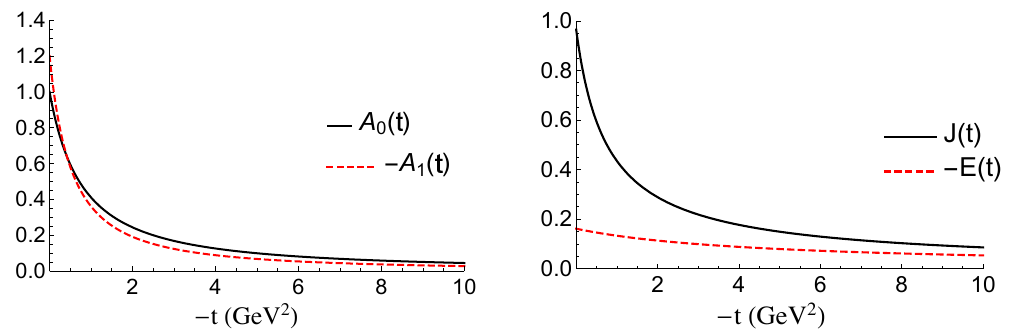
( t ) and A ( t ) , and (b) J ( t ) and E ( t ) . 0 1